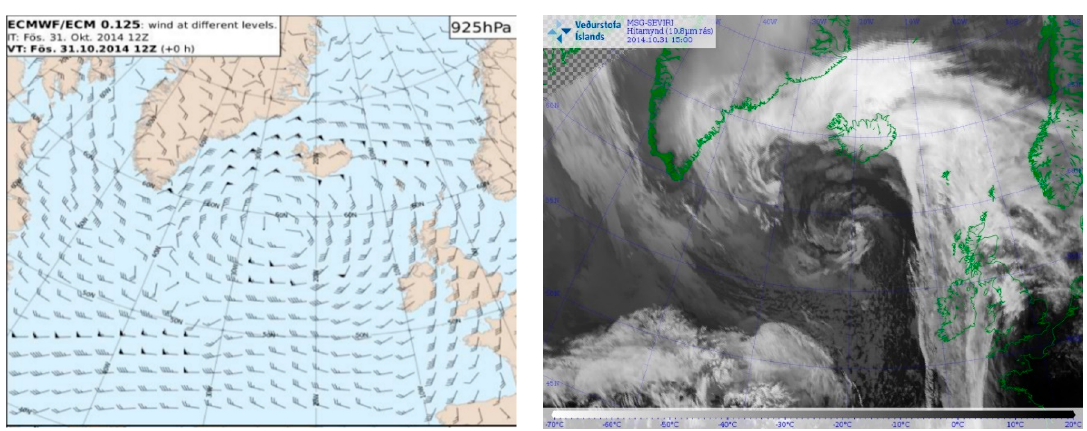
Figure 13. ECMWF low-level wind field (925 hPa / ~750 m) ANALYSIS (00 hr forecast) on 12Z 31 October 2014 ( left ) and MSG-SEVIRI IR satellite imagery at 15Z ( right ) when the DC-8 was just off the tip of Greenland (Images and Data processed by the Icelandic Meteorological Office).